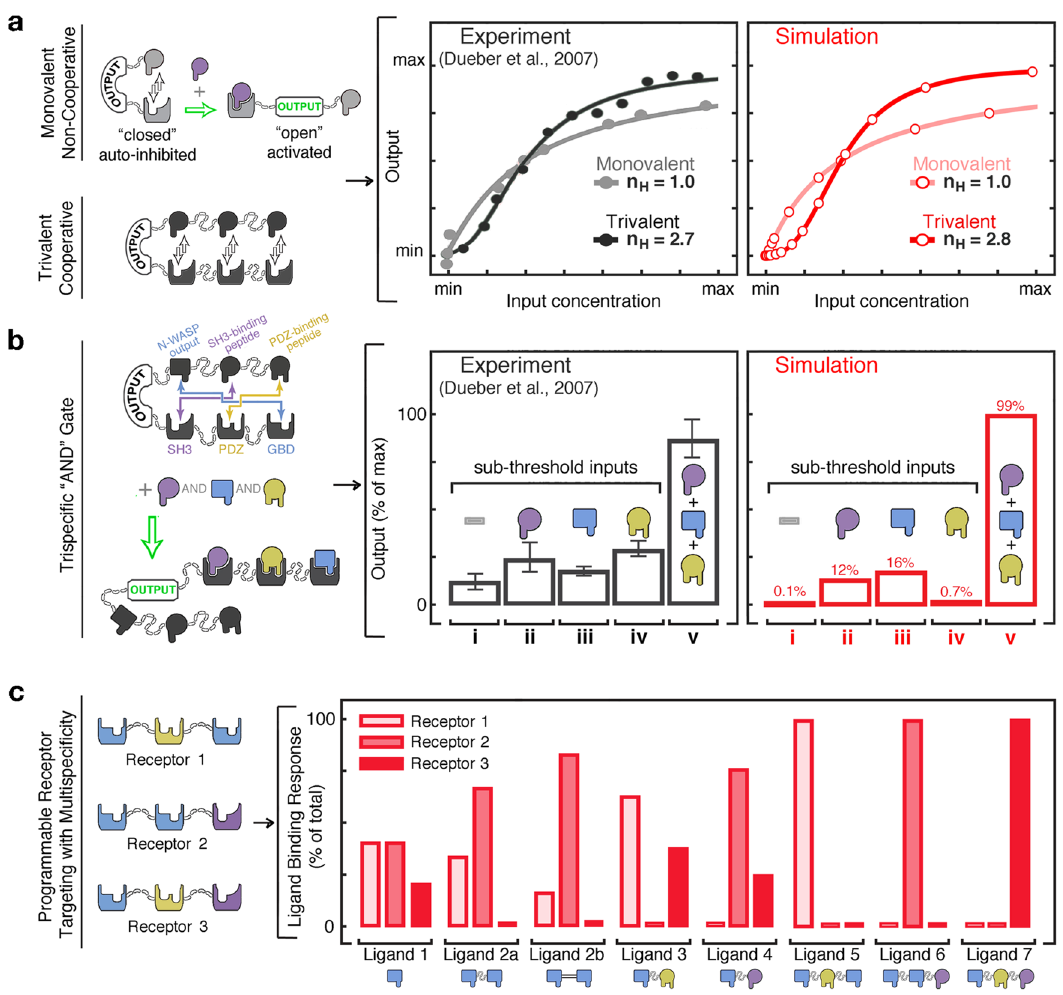
Fig. 4 | MVsim predicts and informs the design of switch-like dynamics, logic operations, and target-receptor selectivity implicit to multivalent systems. a Experimental response dynamics of synthetic monovalent and trivalent switches from ref. 31 were used to benchmark the predictive performance of MVsim simulations described by the reported structural, topological, and kinetic parameters. Ultrasensitivity of each simulated response is reported with a cal- culated Hill coef fi cient ( n H ) for direct comparison with the reported literature values. b Experimental output responses for a trispeci fi c AND logic gate, also from ref. 31, benchmarked against an identically parameterized system in MVsim . For clarity, the AND gate is depicted (diagram, top left) in its originally designed twisted con fi guration (detailed in Supplementary Fig. 6). Simultaneous addition